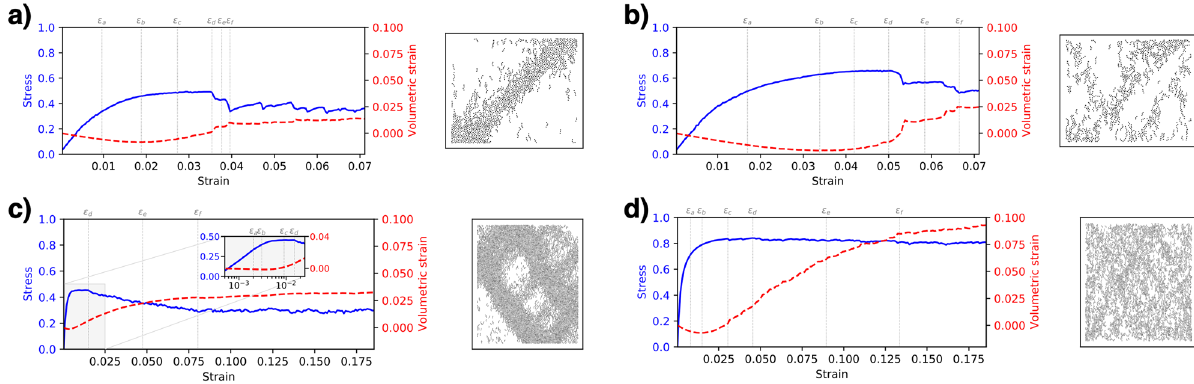
Figure 7. Change of stress and volumetric strain with the growth of loading (left) and the final shearbands (right) in the studied systems: ( a ) 5K, ( b ) 5K-SR, ( c ) 20K, and ( d ) 20K-NR. The inset in panel c shows the same information for the early stages of loading, with strain in log scale for ease of presentation. ε a , . . . , ε f indicate different stages during the loading: ε b is the stage where volumetric strain hits its minimum, ε d is the peak stress stage, and ε f is the end of post-peak softening stage, as marked by the switching of volumetric strain to a flatten curve. The shearbands are identified as the accumulated buckling force chains exceeding the threshold buckling angle θ = 1 ◦ till the final stage.